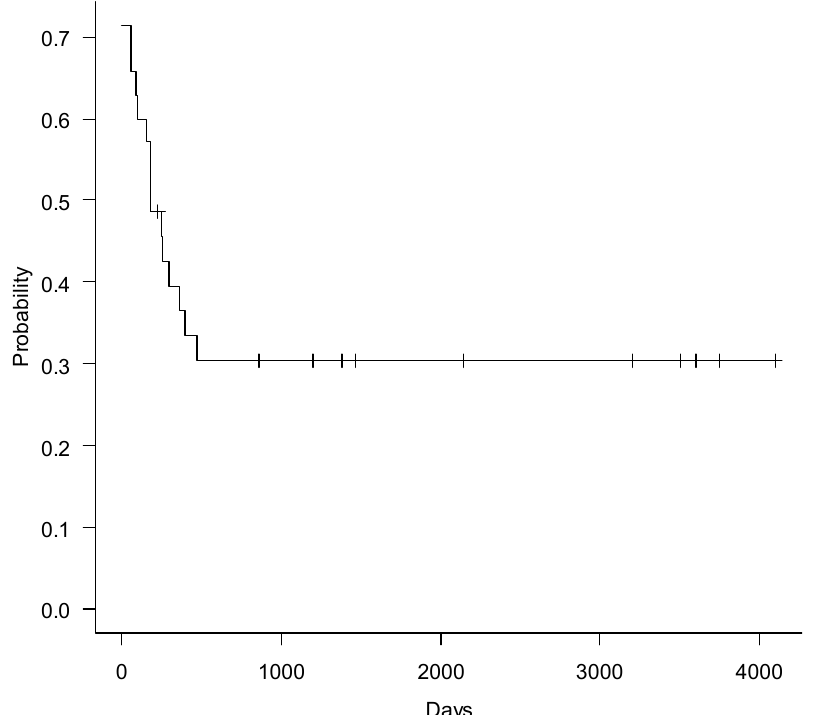
Figure 3. Failure-free survival in children with cGVHD after ECP. Eighteen patients (43%) required correction of IST after ECP treatment, due to insufficient clinical effect. Only response to ECP was associated with improved OS ( p =